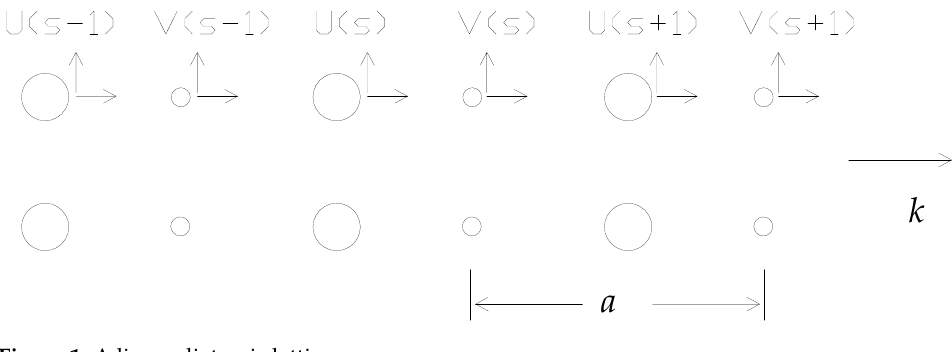
Figure 1. A linear diatomic lattice. The repeat distance is a in the direction of the wave vector k , and the displacements of atoms m 1 are denoted by u s − 1 , u s , u s + 1 , . . . for planes s − 1, s and s + 1, whilst those of atoms m 2 are given by v s − 1 , v s and v s + 1 . The problem is then one-dimensional. For each wave vector, there are three modes, one of longitudinal polarisation and two of transverse polarisation. For each polarisation mode, the dispersion relation ω − k develops two branches, known as acoustic and optical branches. There are longitudinal LA and transverse acoustic TA modes and longitudinal LO and transverse optical TO modes. For a total of p atoms per unit cell, there are 3 p branches to the dispersion relation: three acoustic branches and 3 p − 3 optical